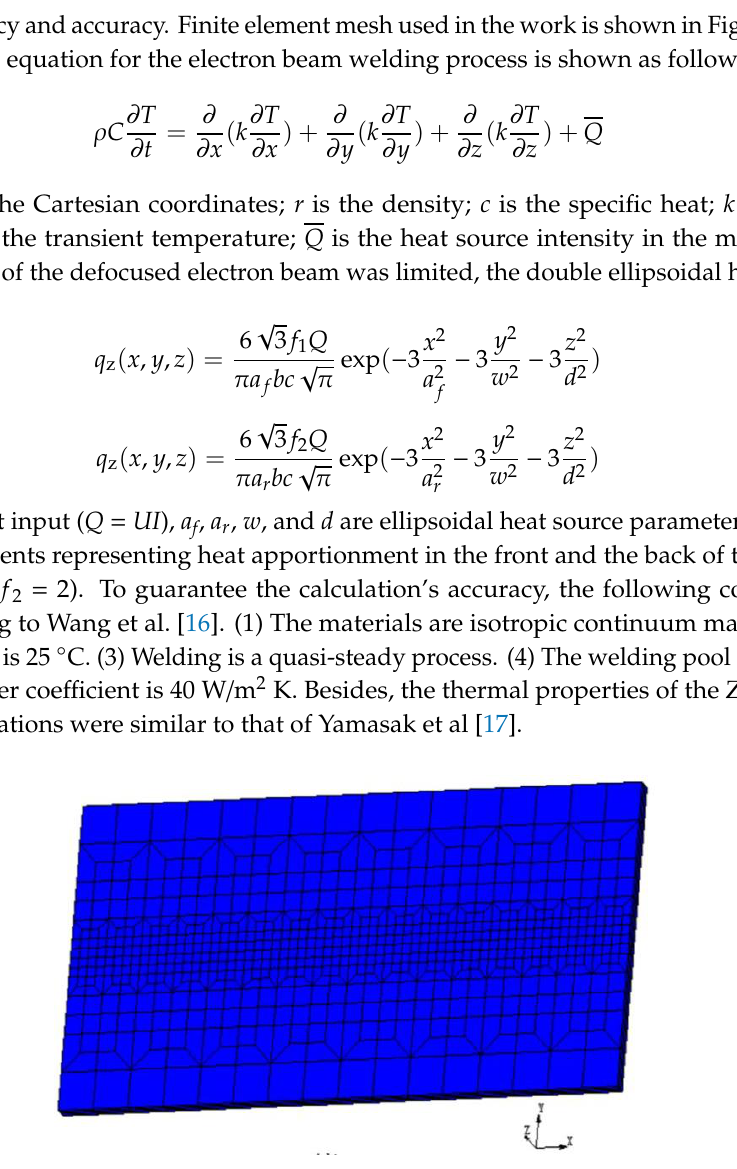
Figure 2. Finite element mesh generation of the welded plate.